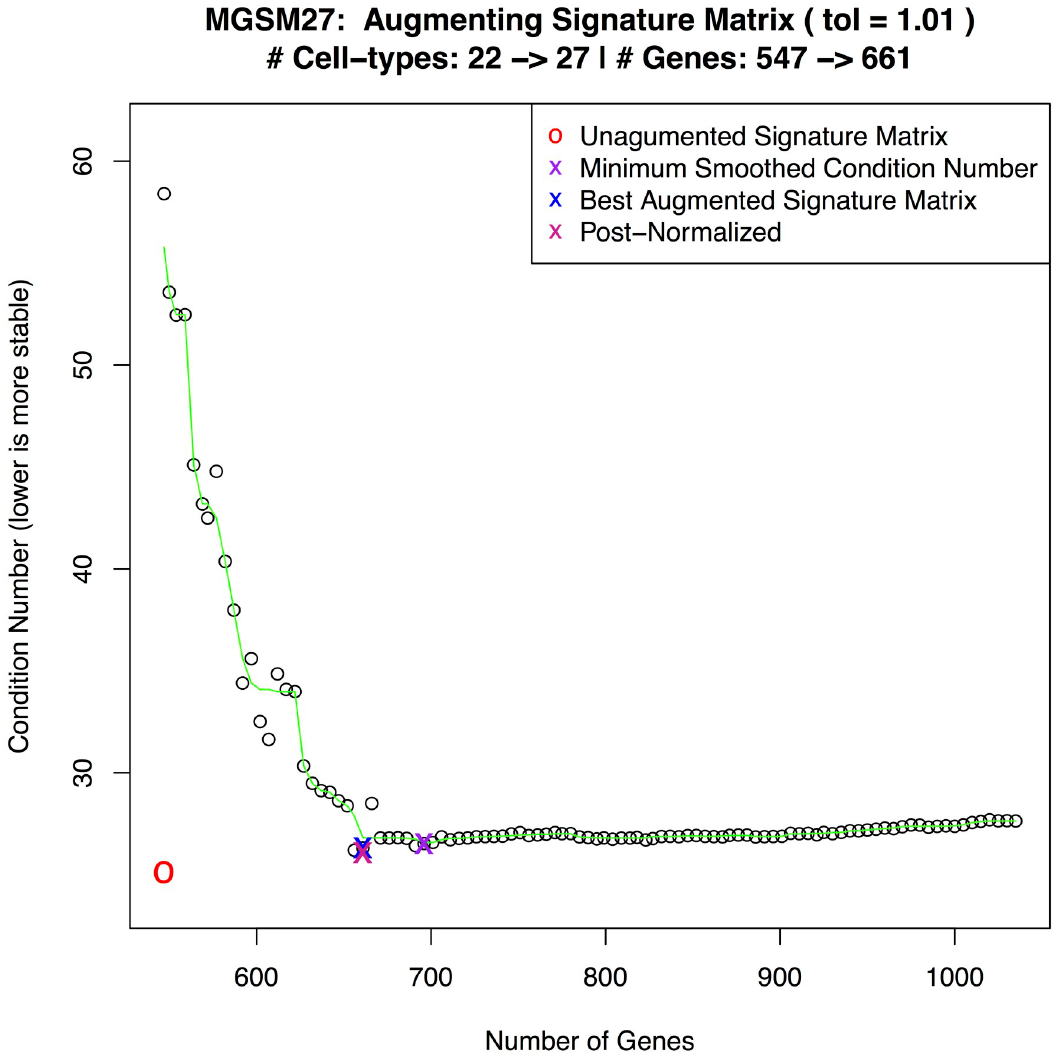
Fig 2. MGSM27 construction. Curve showing the selection of an optimal condition number for MGSM27.